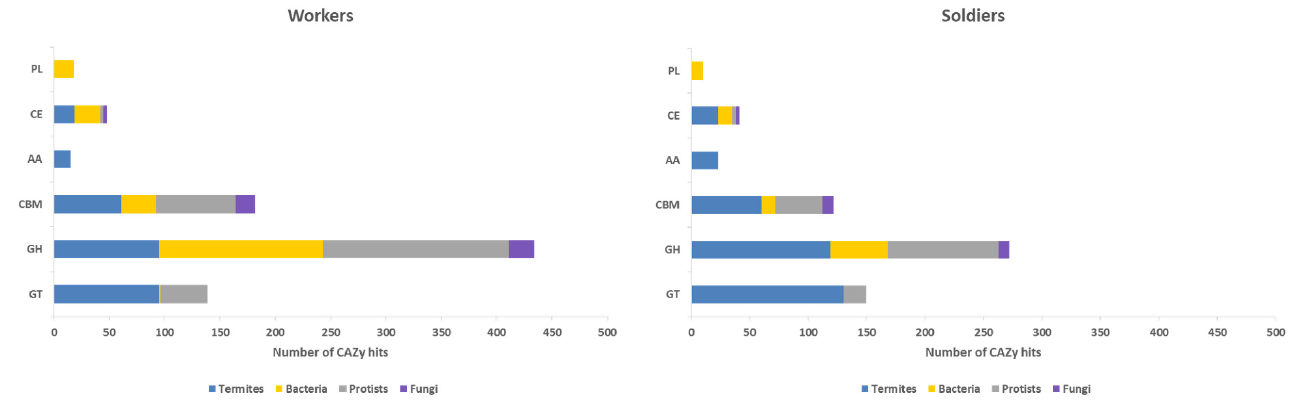
Figure 1. Distribution of CAZy hits across the CAZymes classes found in meta-transcriptomes of H. tenuis workers and soldiers in relation to four taxonomic groups: termites, bacteria, protists, and fungi. PL = Polysaccharide Lyases; CE = Carbohydrate Esterases; AA = Auxiliary Activities; CBM = Carbohydrate-Binding Modules; GH = Glycoside Hydrolases; GT = Glycosyl Transferases. For both castes, GH was the most abundant class of CAZymes. Our data revealed that 337 out of 715 CAZy worker transcripts (47.1%) belong to 38 GH families (Supple- mentary Table S1A). Meanwhile, 153 out of 542 CAZy soldier transcripts (28.2%) belong